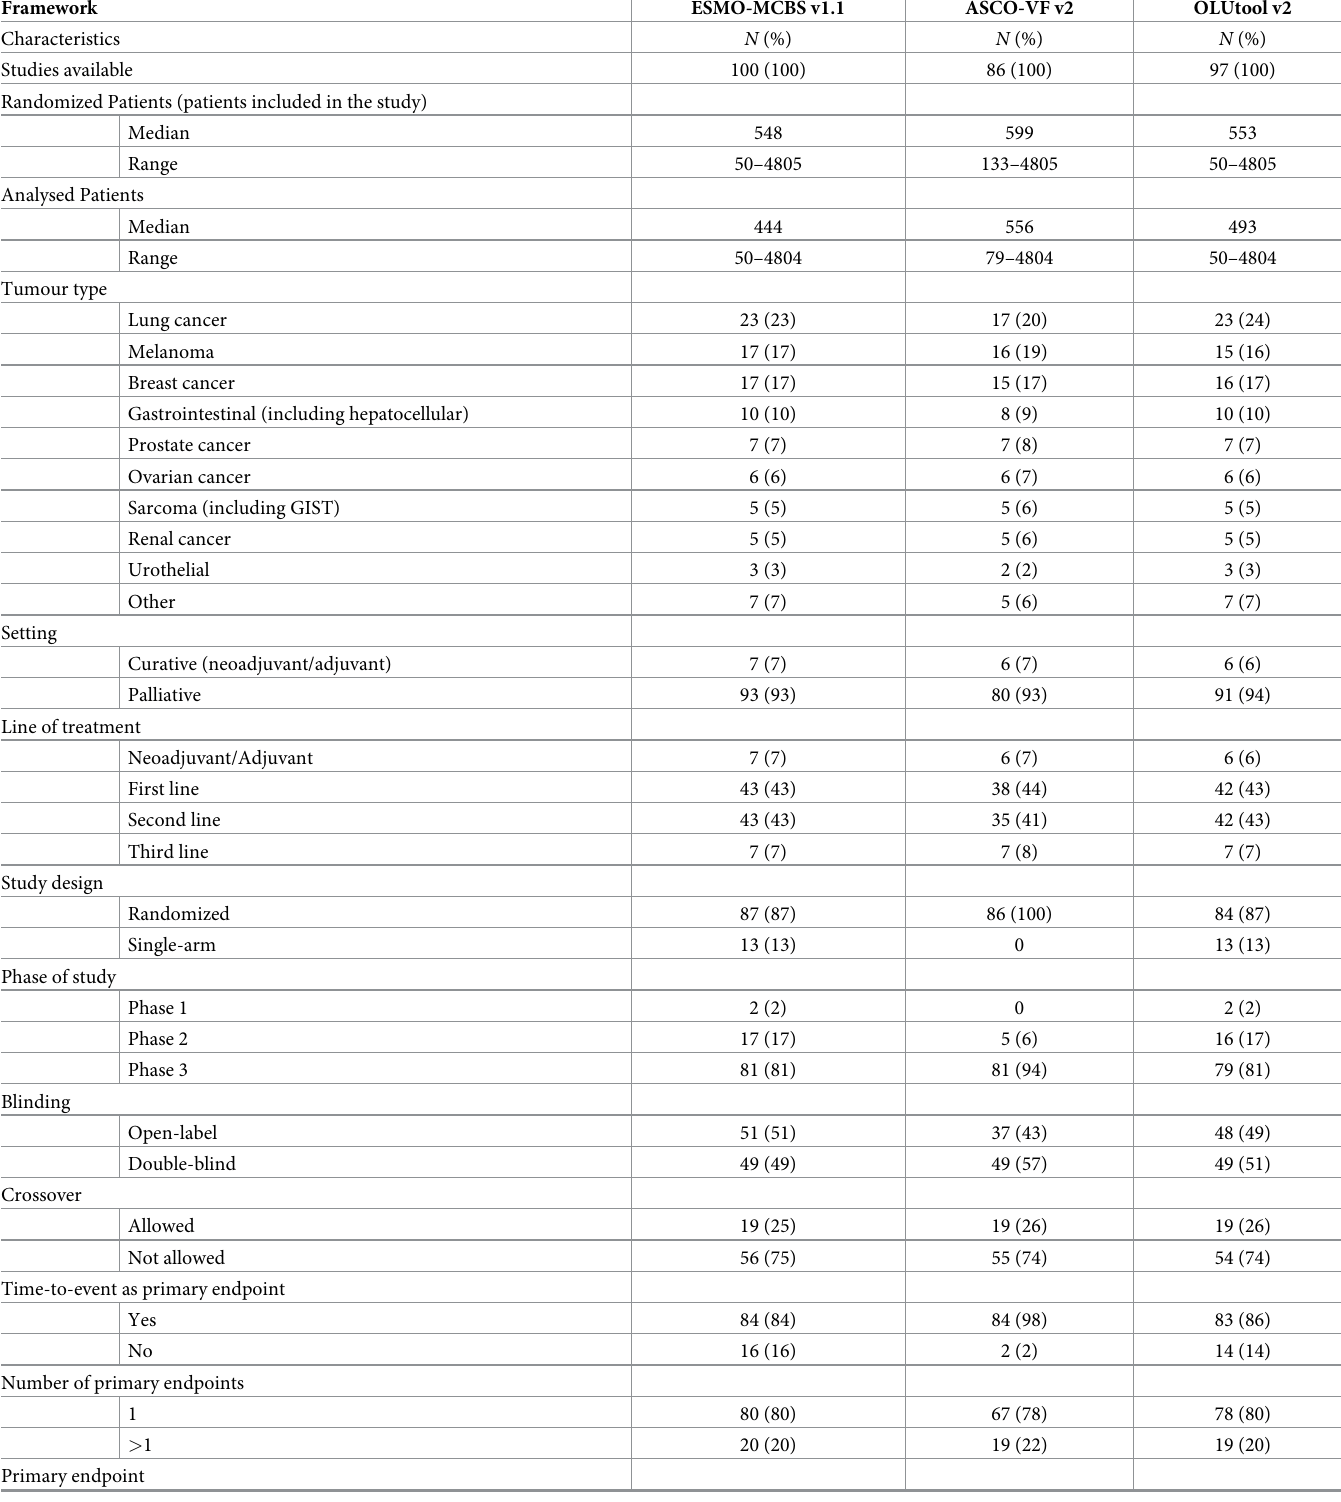
Table 1. Characteristics of pivotal trials evaluable with the ESMO-MCBS v1.1, the ASCO-VF v2 and the OLUtool